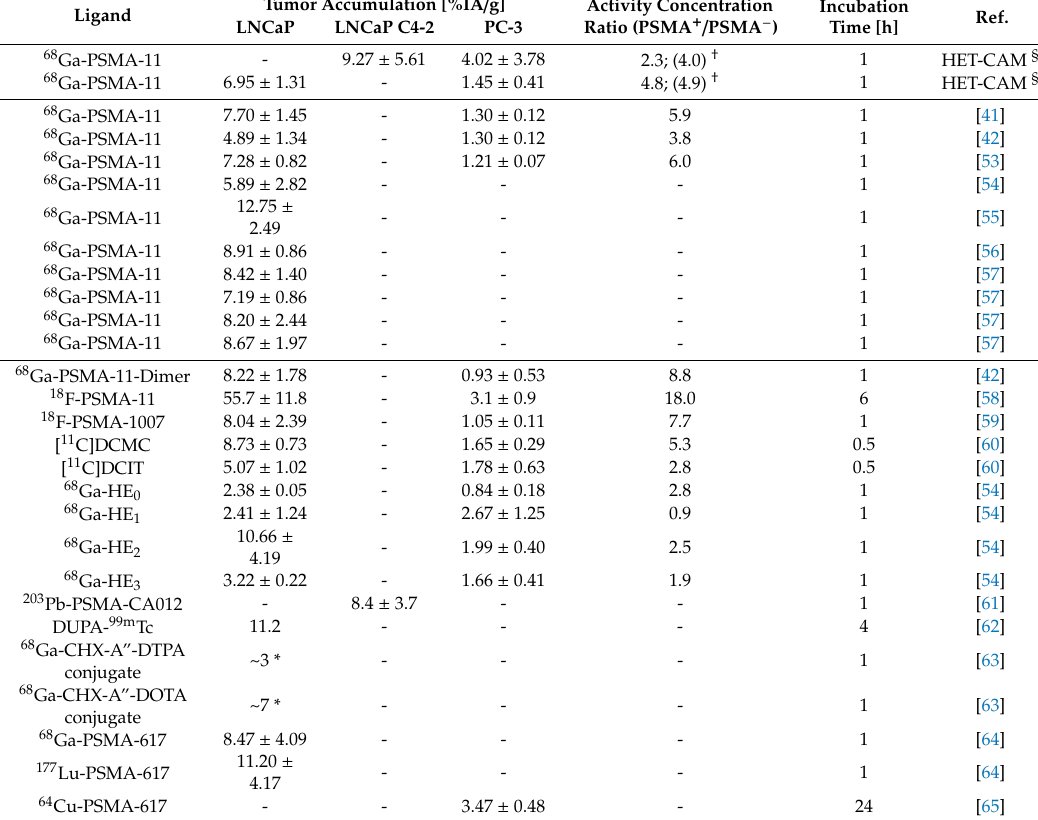
Table 2. Animal experiments in mice using [ 68 Ga]Ga-PSMA-11 (Glu-NH-CO-NH-Lys(Ahx)-HBED-CC) or a similar PSMA-specific tracer in comparison to the present HET-CAM study (mean ± SD). The activity concentration ratios have been calculated based on the published